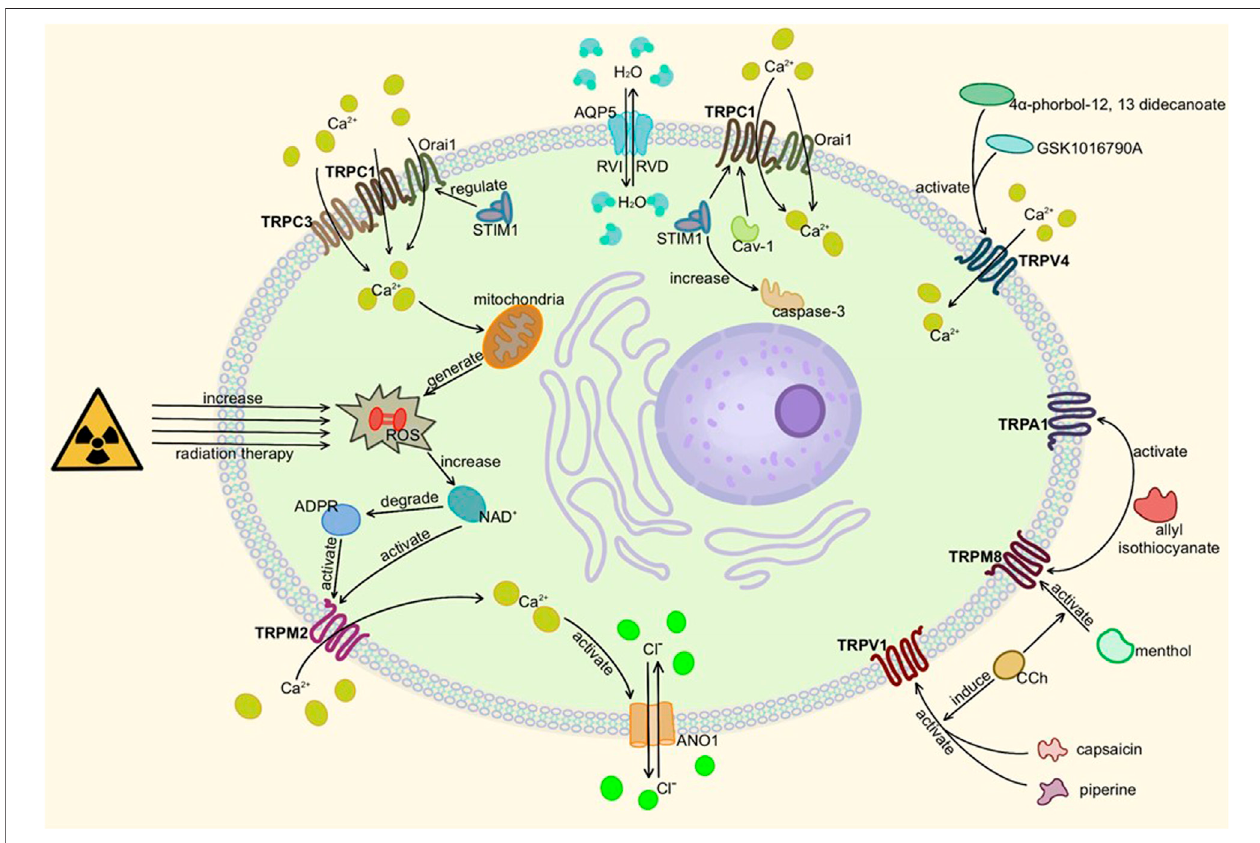
FIGURE4| Activation ofTRPchannels insalivaryglands. Here issalivaryacinar cell(TRPC3 ispresent induct cells). WhenTRPM2,TRPC1, TRPC3,or TRPV4 are activated and mediate Ca 2+ in fl ux, ANO1 and other ion transport channels can be activated to change osmotic pressure and secrete or absorb water through AQP5. TRPA1, TRPV1, and TRPM8 also affect cell secretion but remain to be studied. In addition, too much ROS can damage gland cells, resulting in secretion